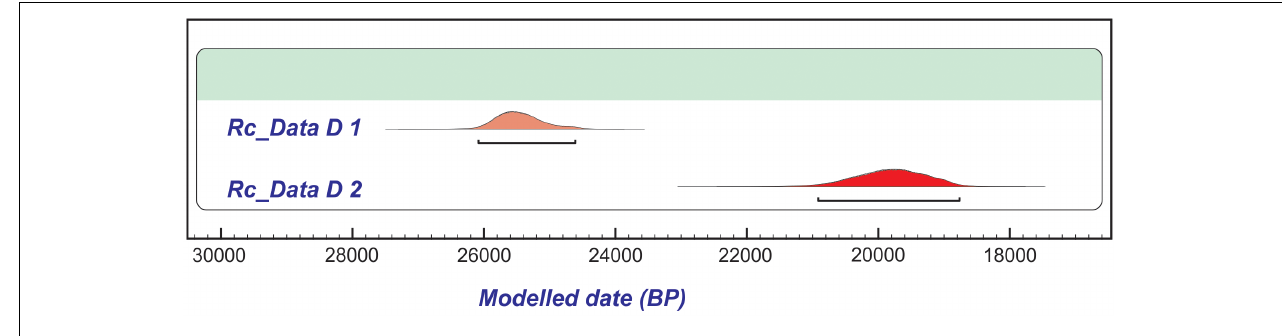
FIGURE 2 | Age model obtained for AMS radiocarbon ages using Oxcal version 4.2.4 (Bronk Ramsey,